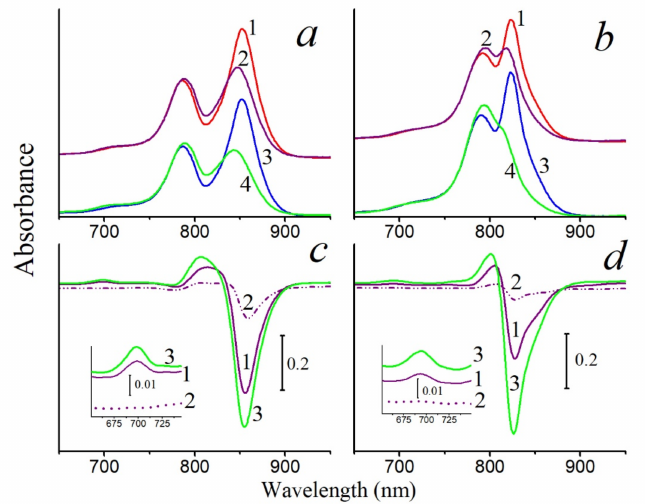
Figure 2. ( a ), Absorption spectra of the control LH2 complex of T . sibirica before (1, 3) and after illumination for 30 min in the presence of 50 µ M RB (2) and blue light (4); ( b ), absorption spectra of the control LH3 complex of T . sibirica before (1, 3) and after illumination for 30 min in the presence of 50 µ M RB (2) and blue light (4); ( c )—differential absorption spectra of the LH2 complex of T . sibirica under illumination: 1—“30 min in the presence of 50 µ M RB minus 0 min”; 2—“30 min in the